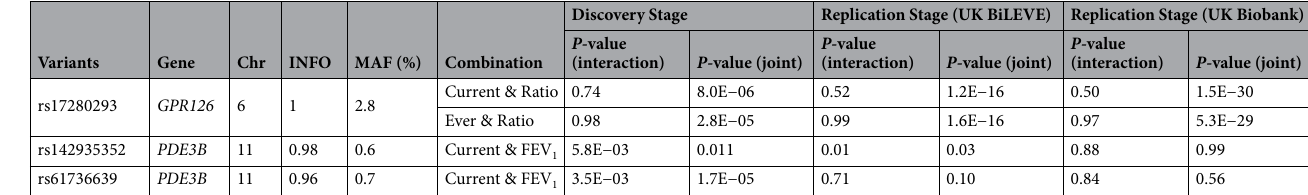
Table 4. Single variant analysis for the identified significant